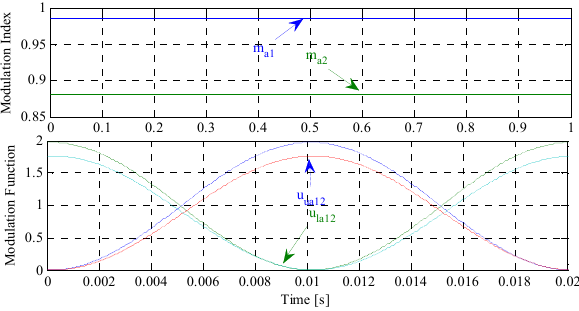
Figure 7. The proposed modulation index and function based on input variable variations.